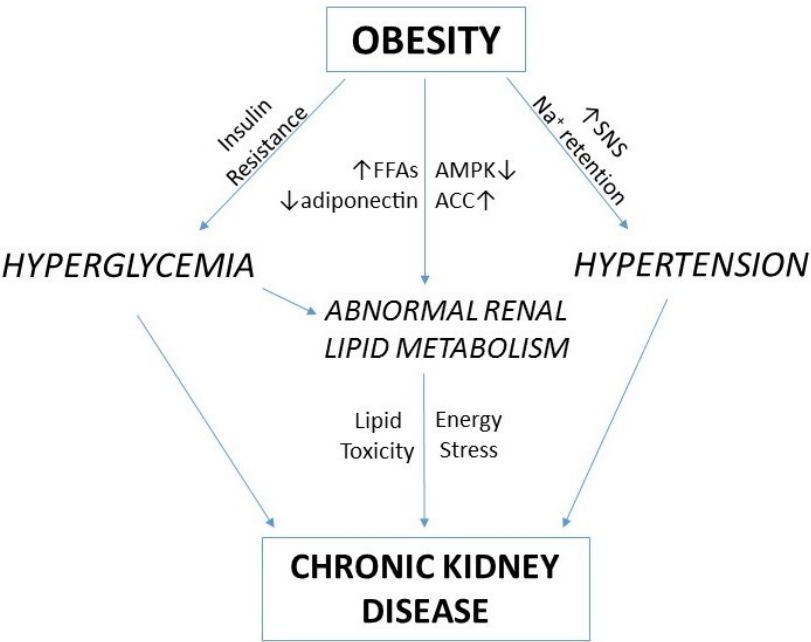
Figure 3. A proposed pathogenesis of obesity-related chronic kidney disease. Obesity leads to CKD through both systemic effects such as hypertension and hyperglycemia, and intrarenal effects associated with impaired lipid metabolism. Sodium retention and activation of the sympathetic nervous system (SNS) result in hypertension, whilst insulin resistance causes hyperglycemia. Energy excess associated with increased free fatty acids (FFAs) and reduced adiponectin, reduces the activity of AMP-activated protein kinase (AMPK), thereby increasing the activity of acetyl-CoA carboxylase (ACC). The resulting reduction in fatty acid oxidation and increase in fatty acid synthesis, promotes a situation of lipid toxicity and energy stress which further contributes to the development of